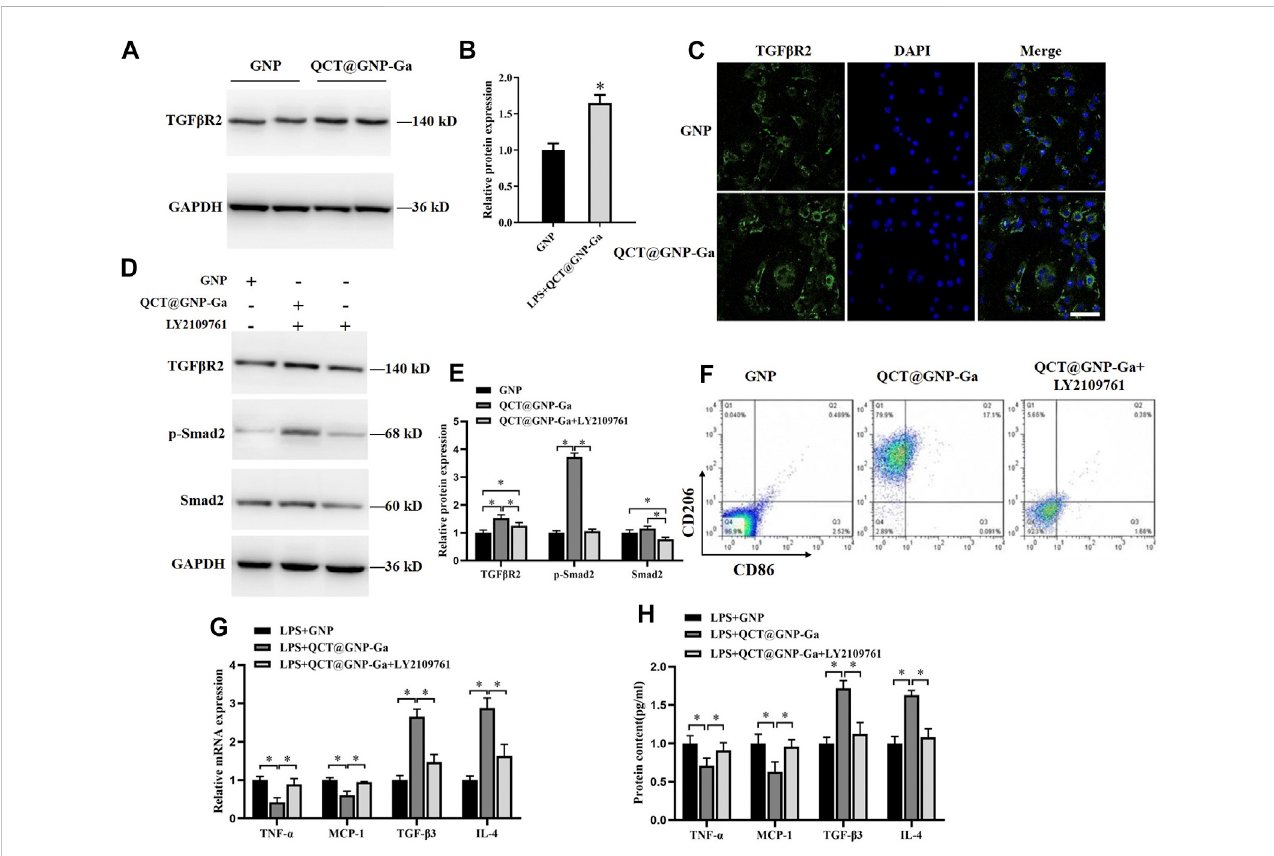
FIGURE 5 Regulation of polarization of macrophages by QCT@GNP-Ga through TGF β /Smad pathway. (A) Western blot analysis, (B) statistical results, and (C) immuno fl uorescent staining analysis of TGF β R2 protein expressions in RAW264.7 cells treated with GNP or QCT@GNP-Ga. (D) Western blot analysis and (E) statistical results of TGF β R2, p-Smad2, and Smad2 protein expressions in RAW264.7 cells treated with GNP or QCT@GNP-Ga. (F) Representative images of FCManalysisofRAW264.7cellstreatedwithGNPorQCT@GNP-GaorLY2109761. (G,H) RelativeexpressionandsecretionofTNF- α ,MCP-1,TGF- β 3and IL-4 after the treatment with GNP or QCT@GNP-Ga or with LY2109761 in LPS-stimulated macrophage. Data are shown as mean ± SD, * p < 0.05, Scale bar = 20 μ